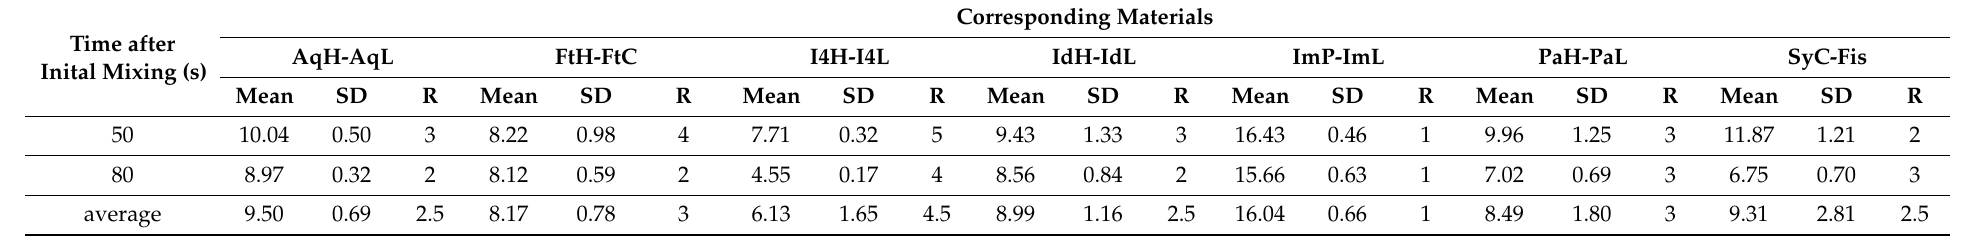
Corresponding Materials